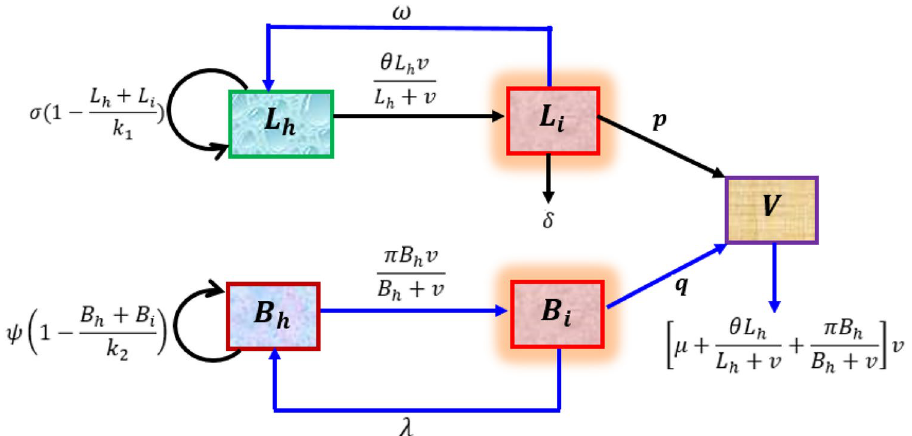
Figure 6. The in-host dynamics of